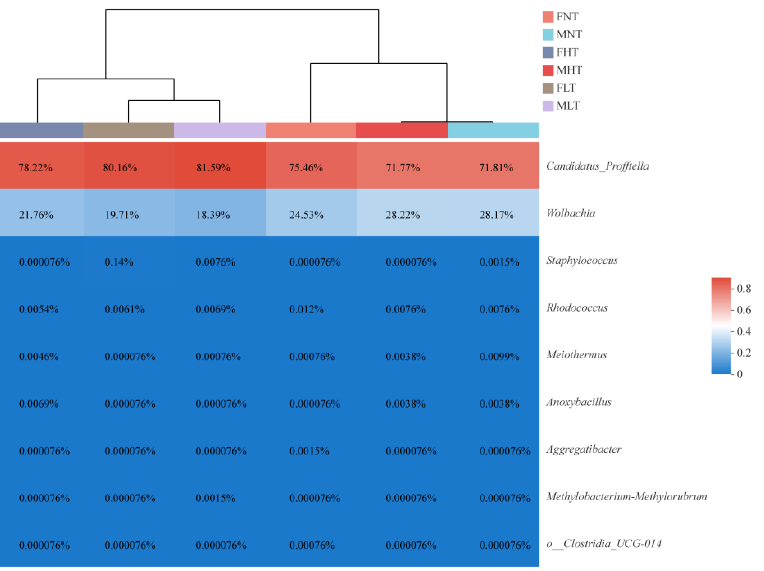
Figure 3. Impact of different temperature treatments of D. citri on the compositions of bacterial communities. The colors indicate the relative abundance, ranging from blue – gray (a lower relative abundance) to red – gray (a higher relative abundance). The dominant ASV proportion in male and female adults of D. citri under different temperature treatments and the relative abundances of the bacterial distributions of the top 50 abundant genera present in the microbial community are depicted. FNT and MNT: female and male under a normal – temperature treatment (26 °C); FHT and MHT: female and male under a high-temperature treatment (42 °C); FLT and MLT: female and male under a low – temperature treatment (15 °C). Every group had four biological replicates of D. citri .